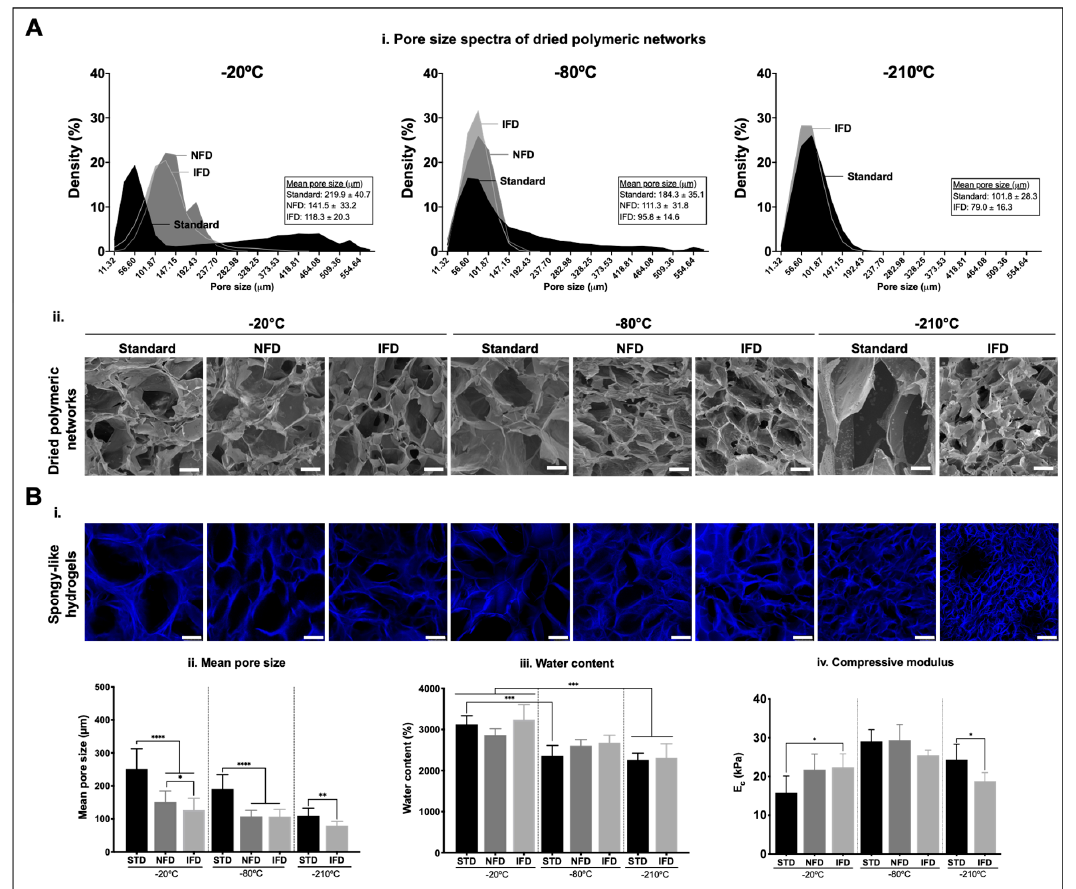
Figure 3. E ff ect of freezing conditions (standard method (STD), NFD, and IFD at − 20, − 80, and − 210 ◦ C) over the properties of 1.25% GG dried polymeric structures and spongy-like hydrogels. ( A ) (i) Pore size spectra and mean pore size obtained from micro-computed tomography ( µ -CT) and (ii) representative scanning electron microscopy micrographs of dried polymeric structures. ( B ) (i) Representative confocal images of the microarchitecture of spongy-like hydrogels after staining with DAPI (blue). Representation of the variations of the (ii) mean pore size obtained from the analysis of images acquired by confocal microscopy, (iii) water content, and (iv) compressive modulus of spongy-like hydrogels prepared under di ff erent freezing conditions. * p < 0.05, ** p < 0.01, *** p < 0.001, **** p < 0.0001, one-way ANOVA with Bonferroni multiple comparison post-test. Scale bar = 75 µ